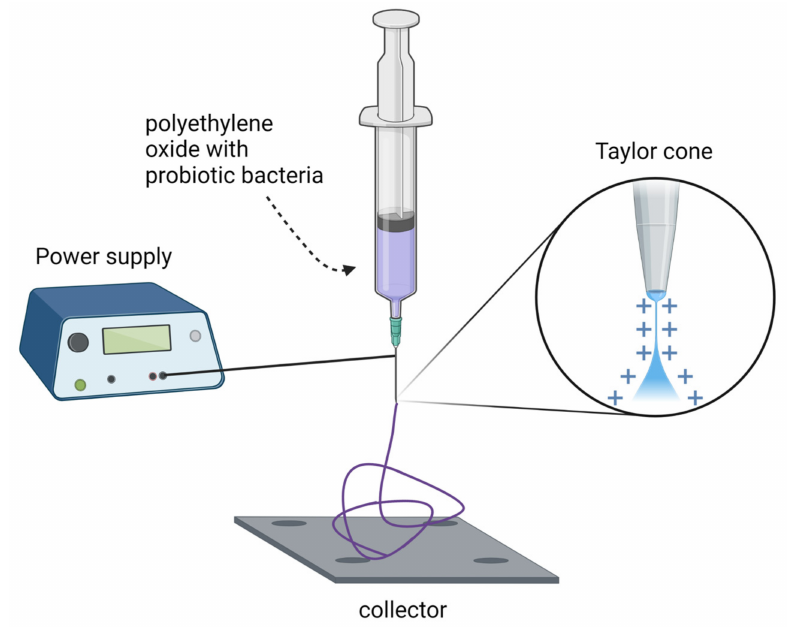
Figure 2. Principal elements of nanofiber fabrication by electrospinning. Created with Biorender.com (accessed on 1 June